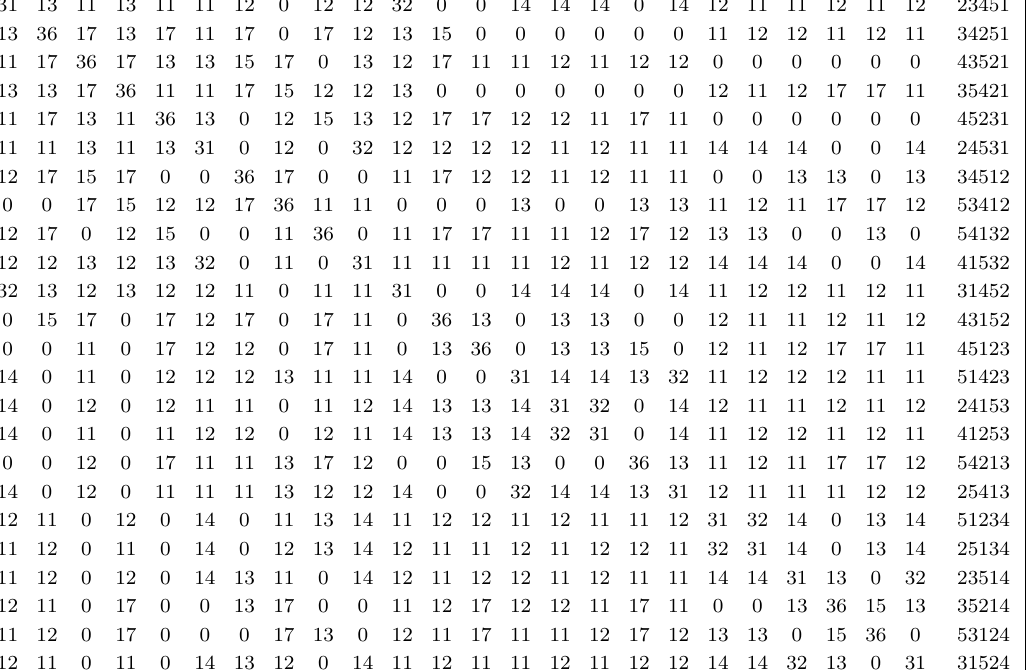
F ( j ) gg , and a single 0 means that c